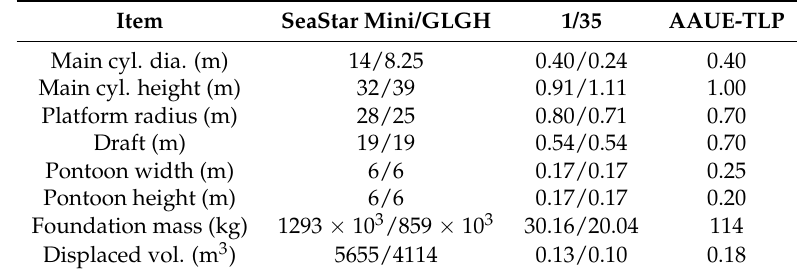
Table 4. TLP properties.